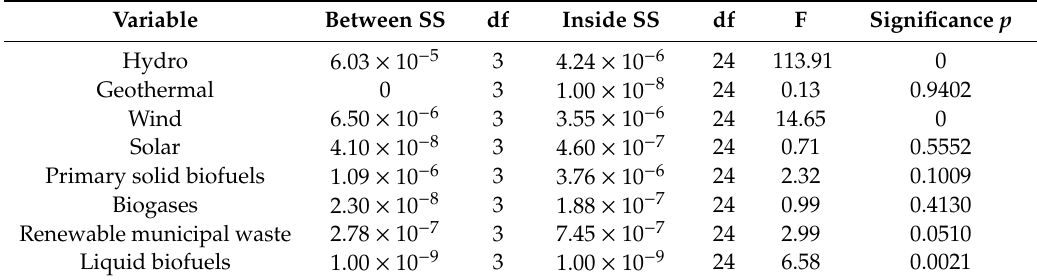
Table 19. Analysis of variance for renewable energy production (own study).